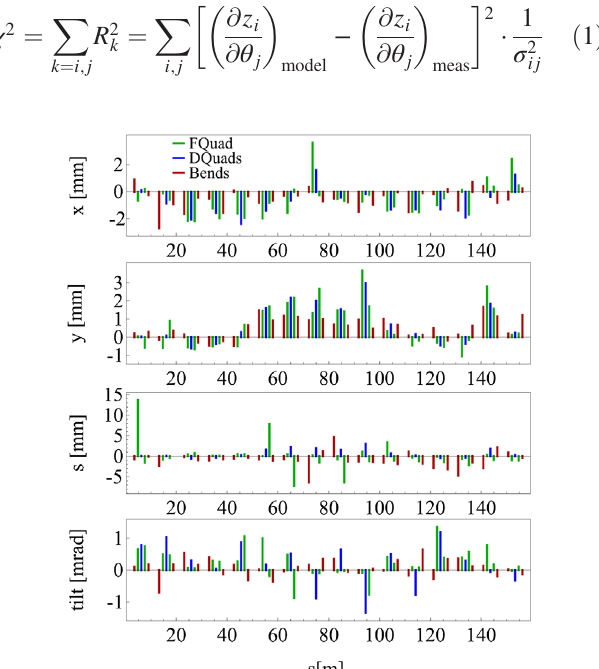
FIG. 1. Transverse and longitudinal alignment errors and tilts of triplet quadrupoles and bending magnets in Ring 2, from May 2013 tunnel